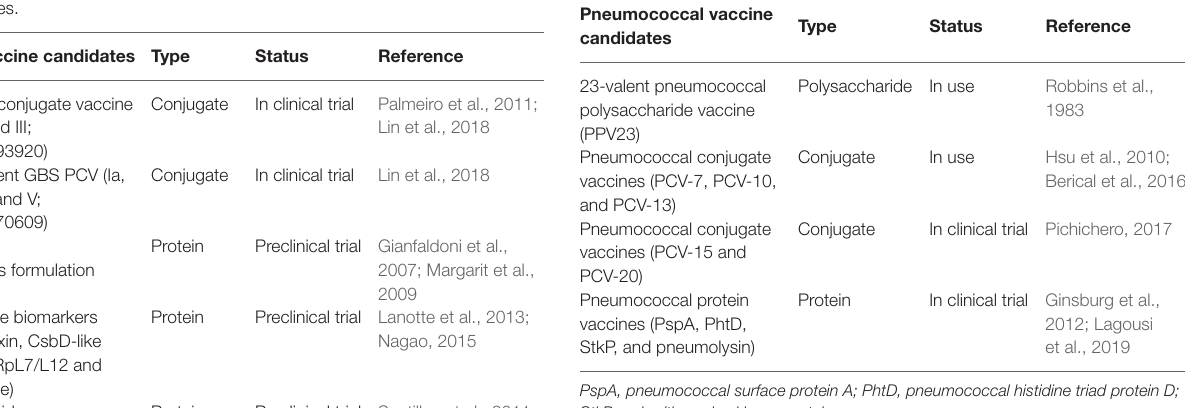
TABLE 1 | Summary of different group B streptococcus (GBS) vaccine candidates.